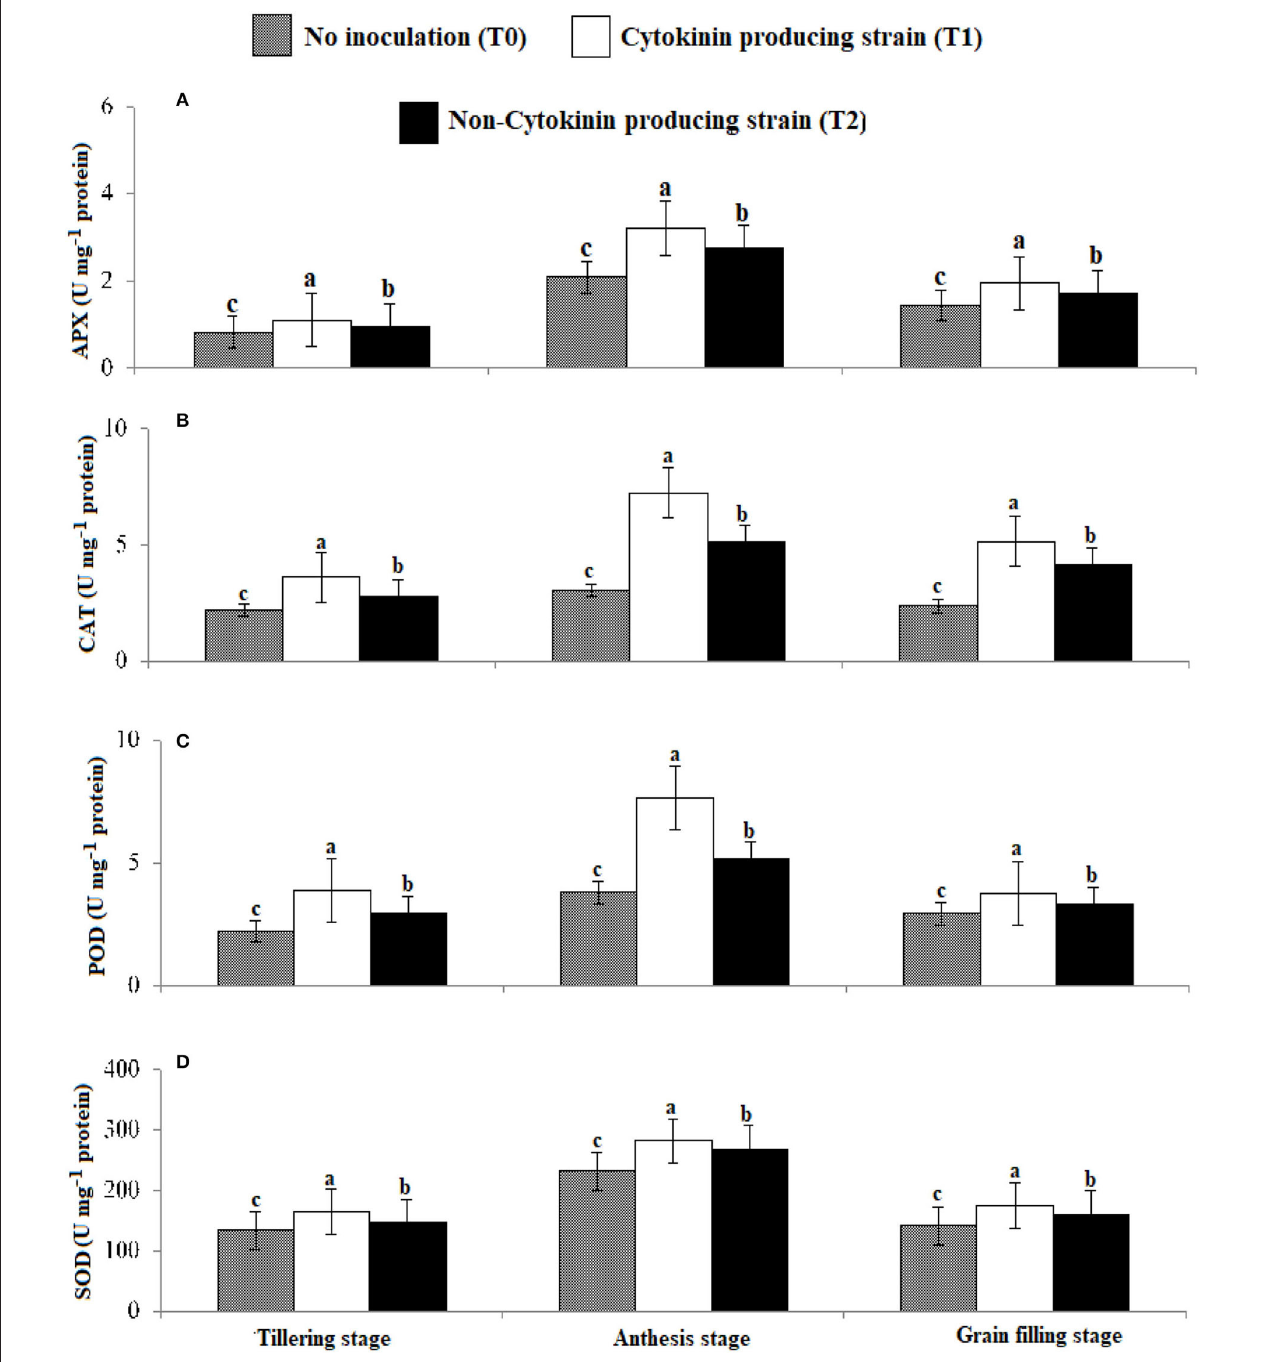
FIGURE 5 | Effect of Ck-producing A. brasilense RA − 17 and non-producing A. brasilense RA − 18 on antioxidant enzymes activities (U mg − 1 protein) of wheat. The different letter shows a significant difference in treatments at a 5% probability